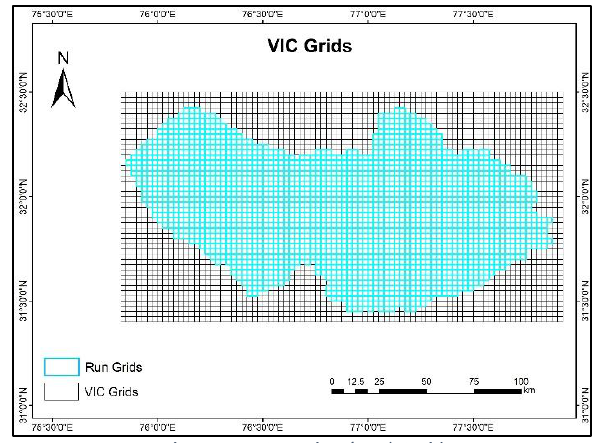
Figure 6 VIC Active (Run)